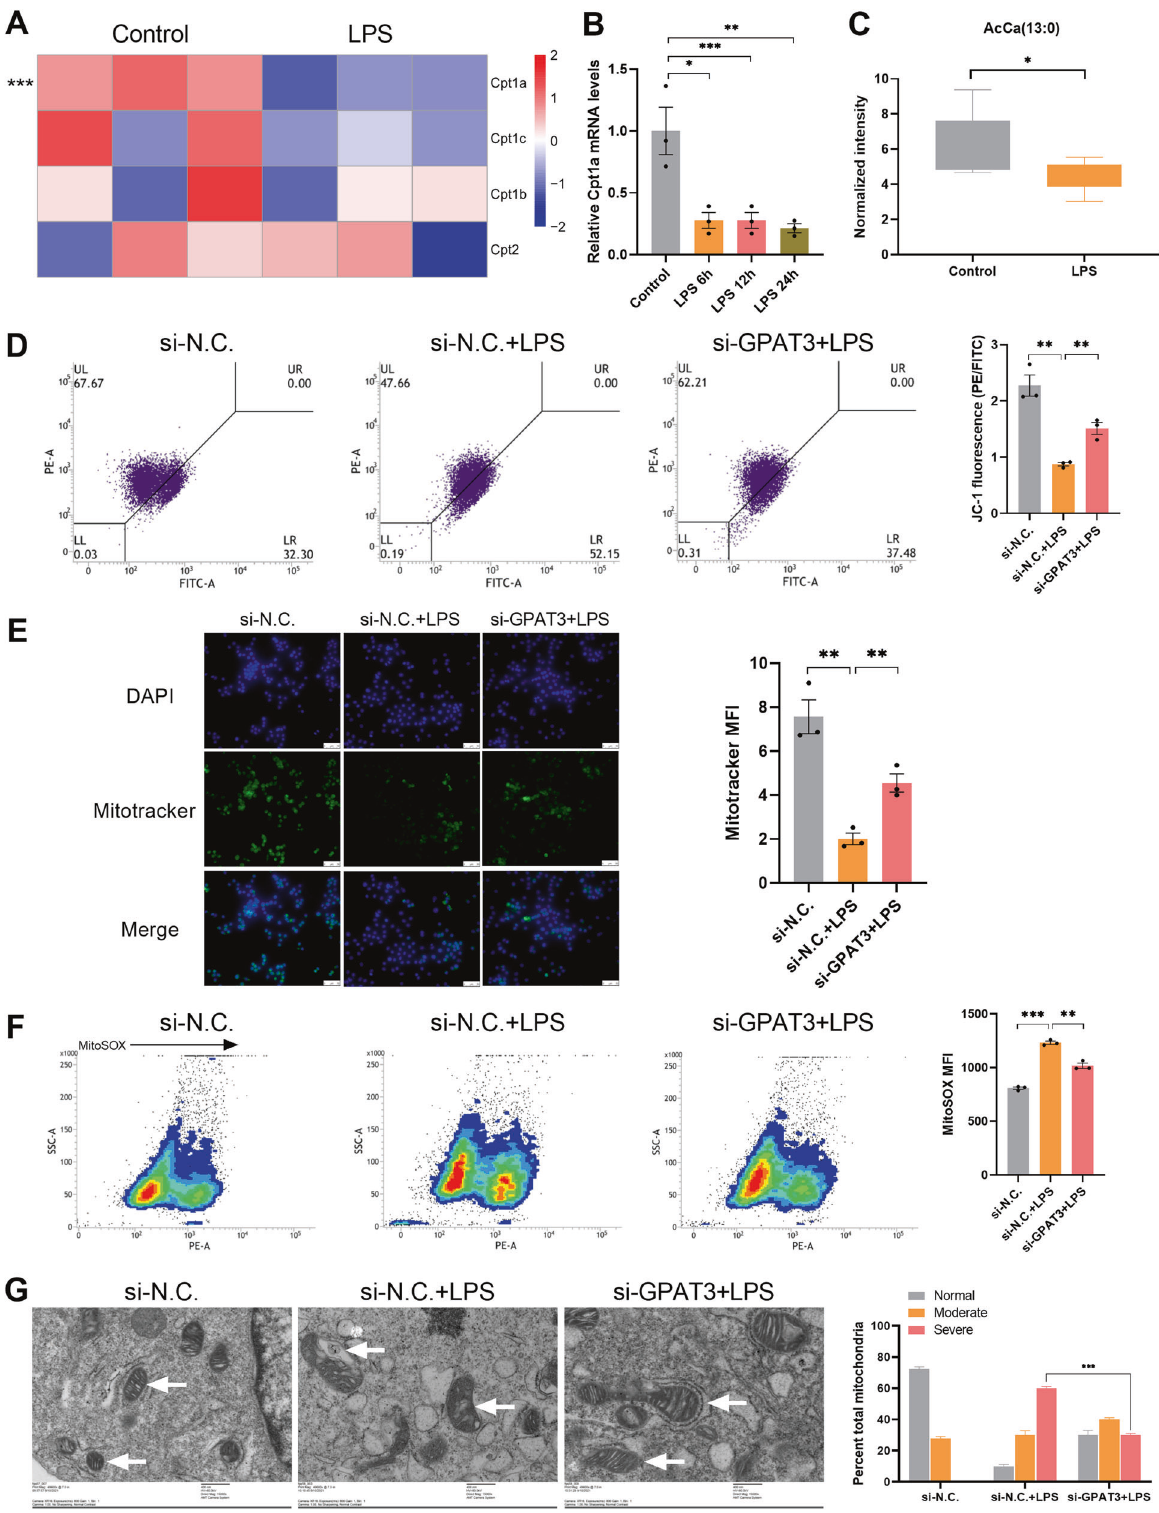
Fig. 3 The loss of GPAT3 function improve mitochondrial function in in fl ammatory Kupffer cells. A Heatmap showing the Cpt1a, Cpt1c, Cpt1b and Cpt2 genes expression in the normal and LPS-stimulated KCs (stimulated with 1 μ g/ml LPS for 24 h) ( n = 3). B qPCR analysis of Cpt1a expression in normal and LPS (100 ng/ml)-stimulated KCs at different time points ( n = 3). C Lipidomics data showing the AcCa (13:0) content with or without LPS (1 μ g/ml 24 h) ( n = 6). D The ratio of PE to FITC indicates the level of mitochondrial membrane potential. JC-1 fl uorescence and F mitochondrial reactive oxygen species (MitoSOX) levels in si-N.C. or si-GPAT3 KCs with or without LPS (1 μ g/ml, 18 h) (MFI, mean fl uorescence intensity) ( n = 3). E Mitotracker fl uorescence visualized by fl uorescence microscopy (scale bars represent 50 μ m) ( n = 3). G Electron microscopy of KCs and quanti fi cation of mitochondrial ultrastructural abnormalities at 18 h post stimulation with LPS without or with si-GPAT3. White arrows, mitochondria (scale bars represent 400 nm) ( n = 3). Data represents mean ± SEM. * P < 0.05, ** P < 0.01, *** P < 0.001. Cell Death and Disease (2023)